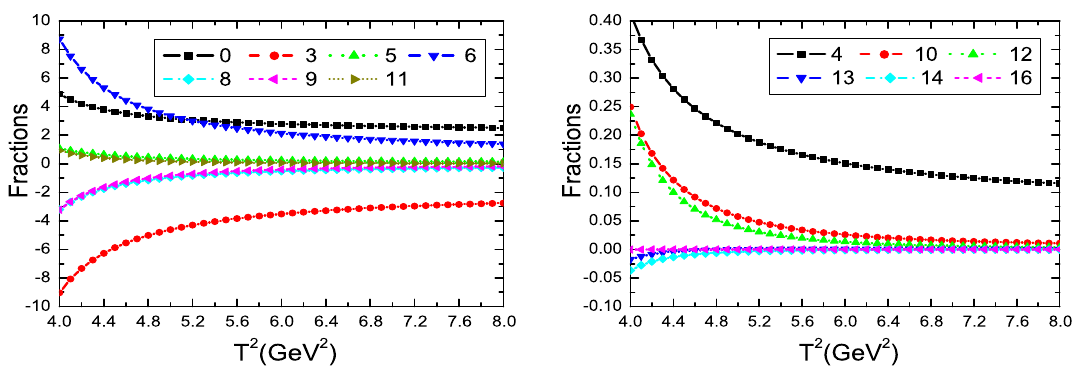
Fig. 4 The contributions of different terms in the operator product expansion with variations of the Borel parameter T 2 , where the 0, 3, 4, 5, 6, ... denote the dimensions of the vacuum